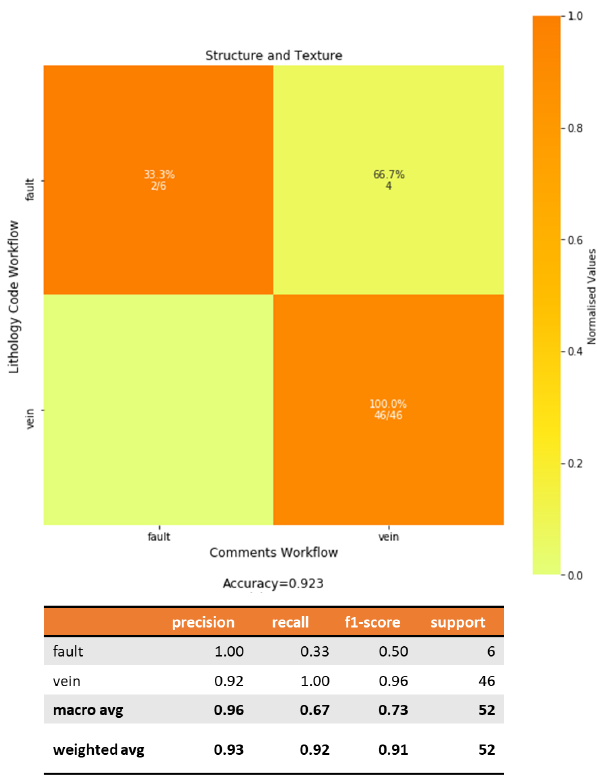
Figure 7. Confusion matrix for structure and texture comparing the fuzzy string matching results from the Lithology Code work- flow (vertical axis) and Comments workflow (horizontal axis). The heatmap shows the values normalized to the support size to address the imbalance between classes. The values shown in the cells indi- cate the number of samples classified for the class. Empty cells indi- cate zero samples. The structures and texture Lithology_Group had an accuracy of 92.3% across 52 samples: 46 for veins and 6 for